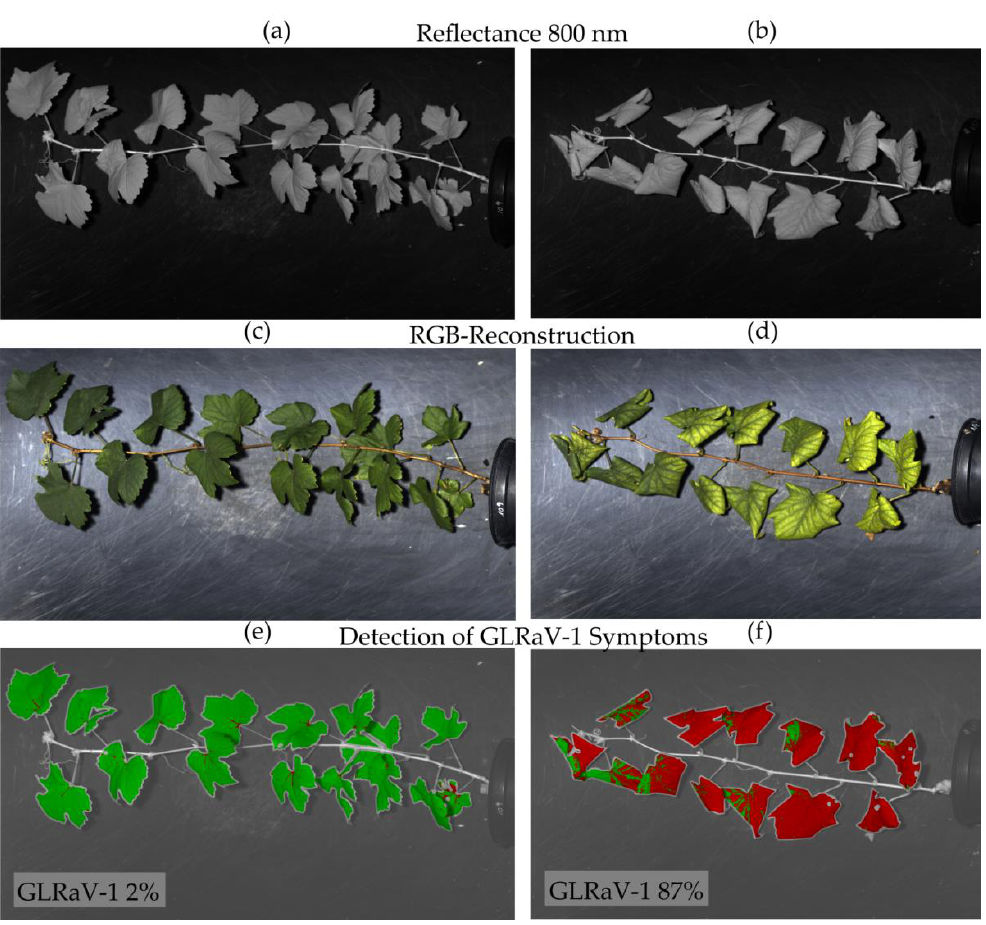
Figure 2. Overview of the workflow for greenhouse data of control (left) and GLRaV-1 infected (right) vines. Depicted are a calibrated reflectance image at 800 nm coded as grey scale ( a , b ) and an RGB reconstruction ( c , d ), which is for visualization only. The hyperspectral image was segmented into its main components and the binary classifier detecting GLRaV-1 was applied to leaf pixels calculating the ratio of symptomatic pixels to all available pixels, thereby, classifying the whole plant as infected or healthy ( e , f ).